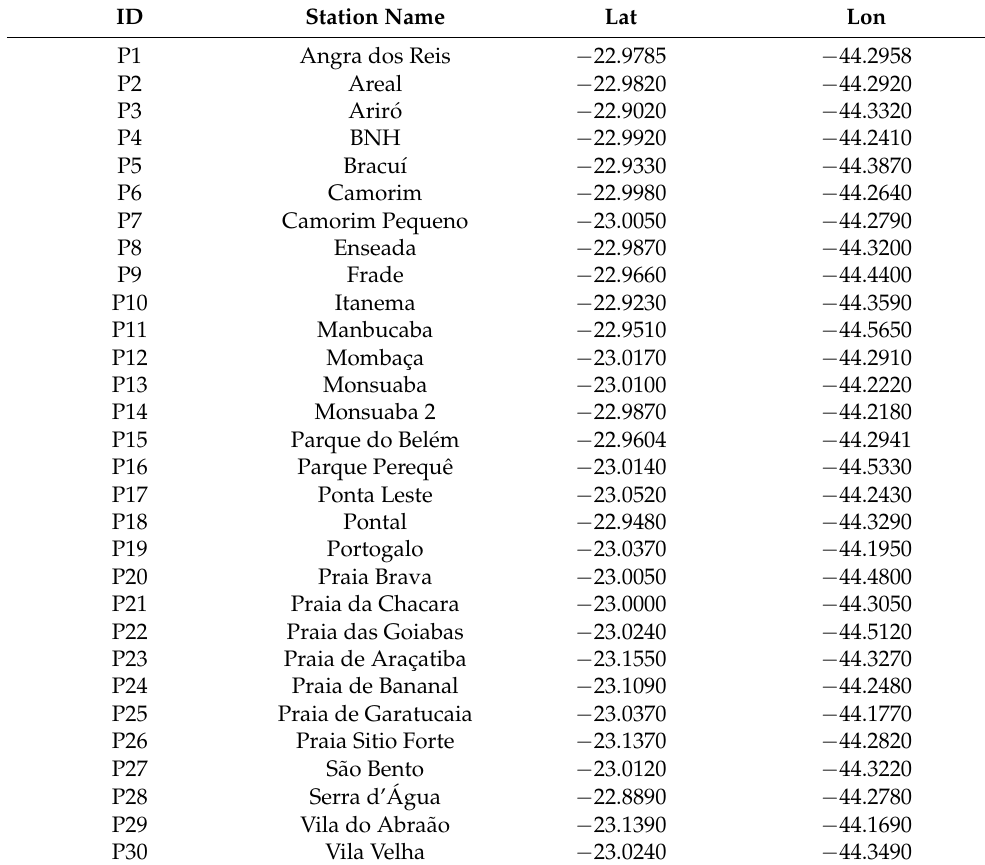
Table 1. Identification, station name, and geographic coordinates of the 30 studied rain